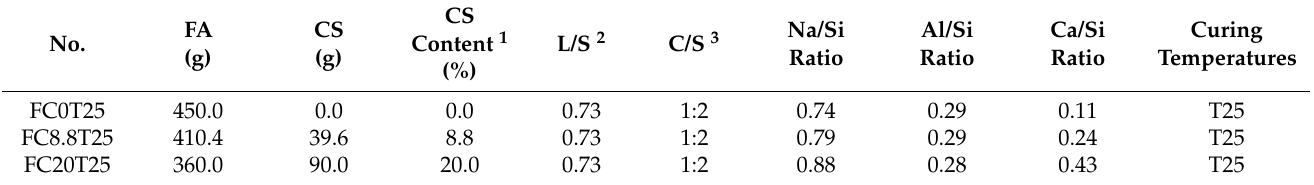
Table 4. Mixing proportions of drying shrinkage